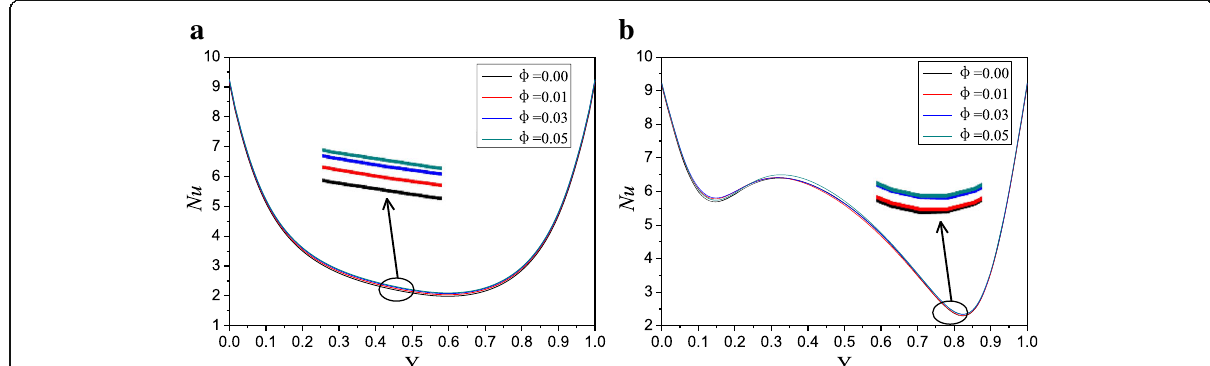
Fig. 7 Nusselt number distributions with different volume fractions, A = 4:1. Nusselt number distributions of Ag-Ga nanofluid with different volume fractions along with the left hot wall, A = 4:1, r = 20 nm. a Ra = 1 × 10 3 . b Ra = 1 × 10 5